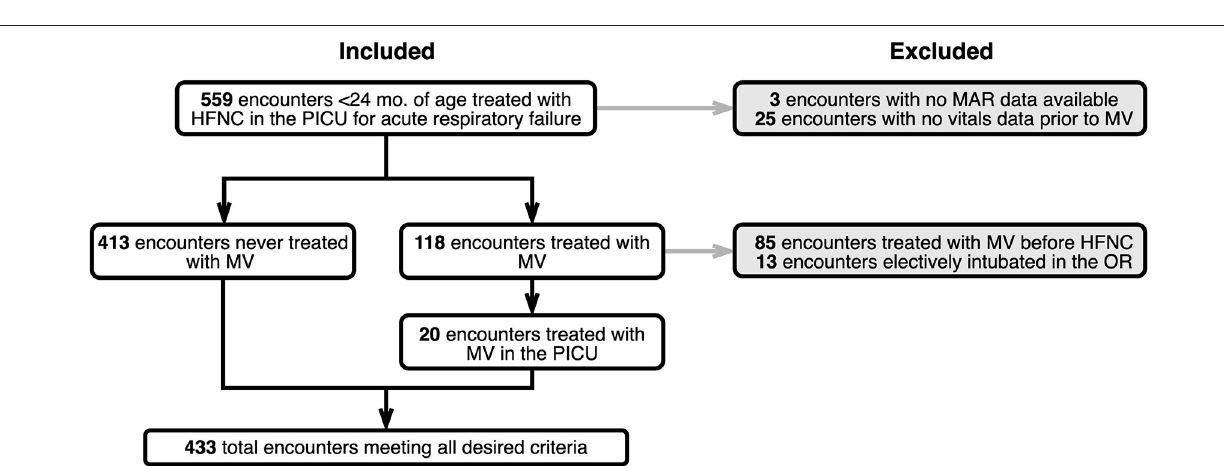
FIGURE 3 | CONSORT diagram depicting study criteria and